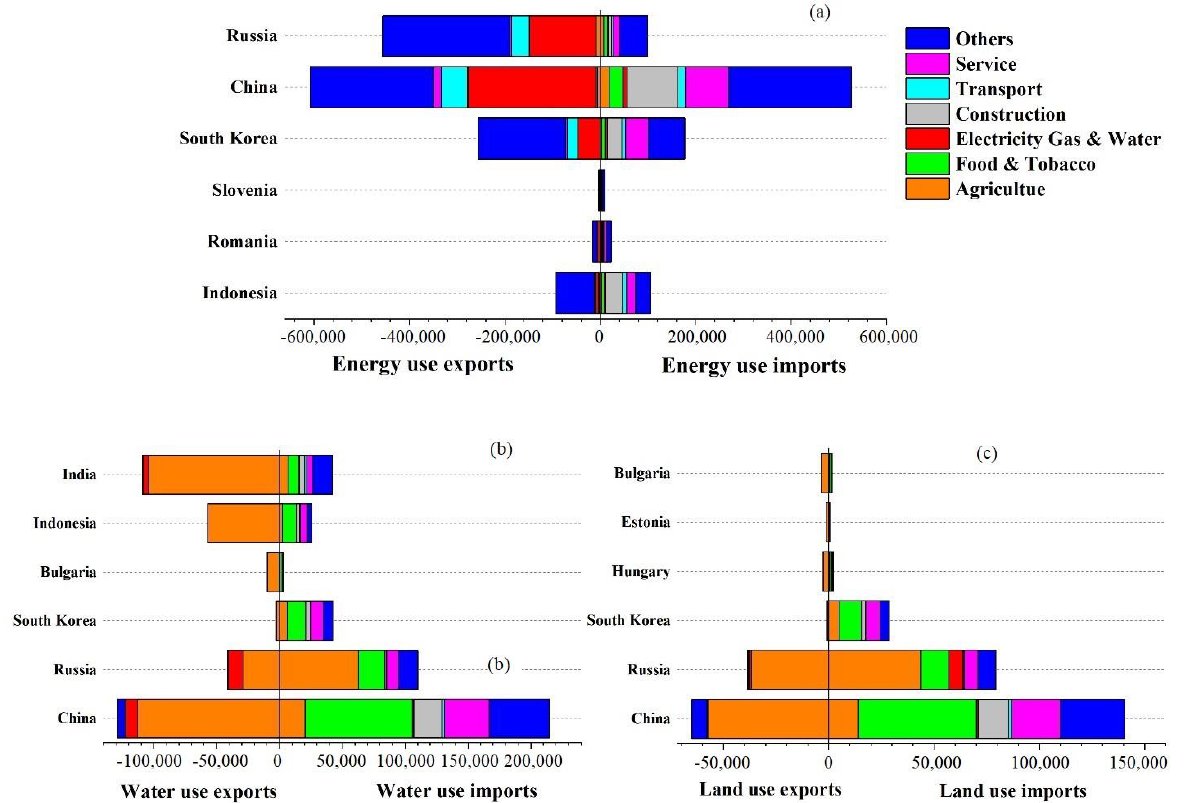
Figure 5. Sectoral contributions to trade of the top three net importers and exporters of energy–water–land use. ( a ) Energy, ( b ) water, ( c ) land.